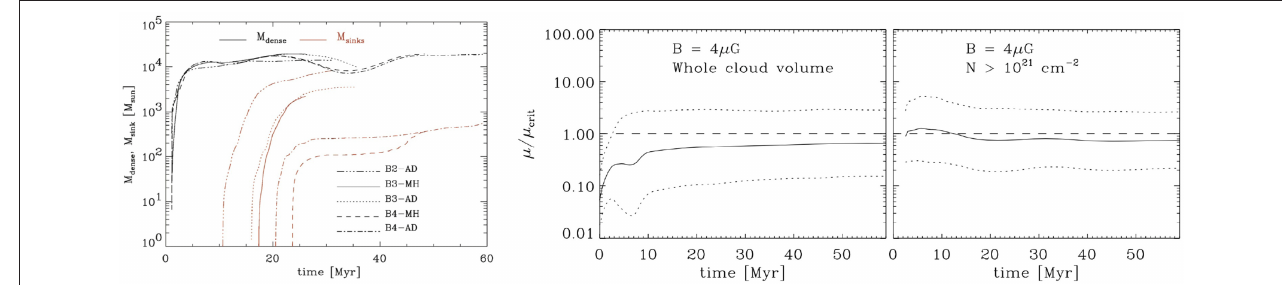
FIGURE 14 | Global flow properties and dense core statistics in a zooming-in calculation that goes from 1 kpc box size to 4 Top-left panel: magnetic intensity vs. density in the whole refined region of the AMR simulation and in 5 star-forming subregions. Top-middle panel: same as top-left panel for the density distribution. Top-right: mass spectrum of dense cores (defined as thermally supercritical objects for 2 different thresholds of their mean density). Bottom-left panel: mass-to-flux ratio vs. mass for the thermally supercritical cores. Bottom-middle: mass-size relation of the thermally supercritical cores. Bottom-right: internal velocity dispersion relation vs. mass of all cores. Reproduced from Hennebelle (2018) with permission of A&A.